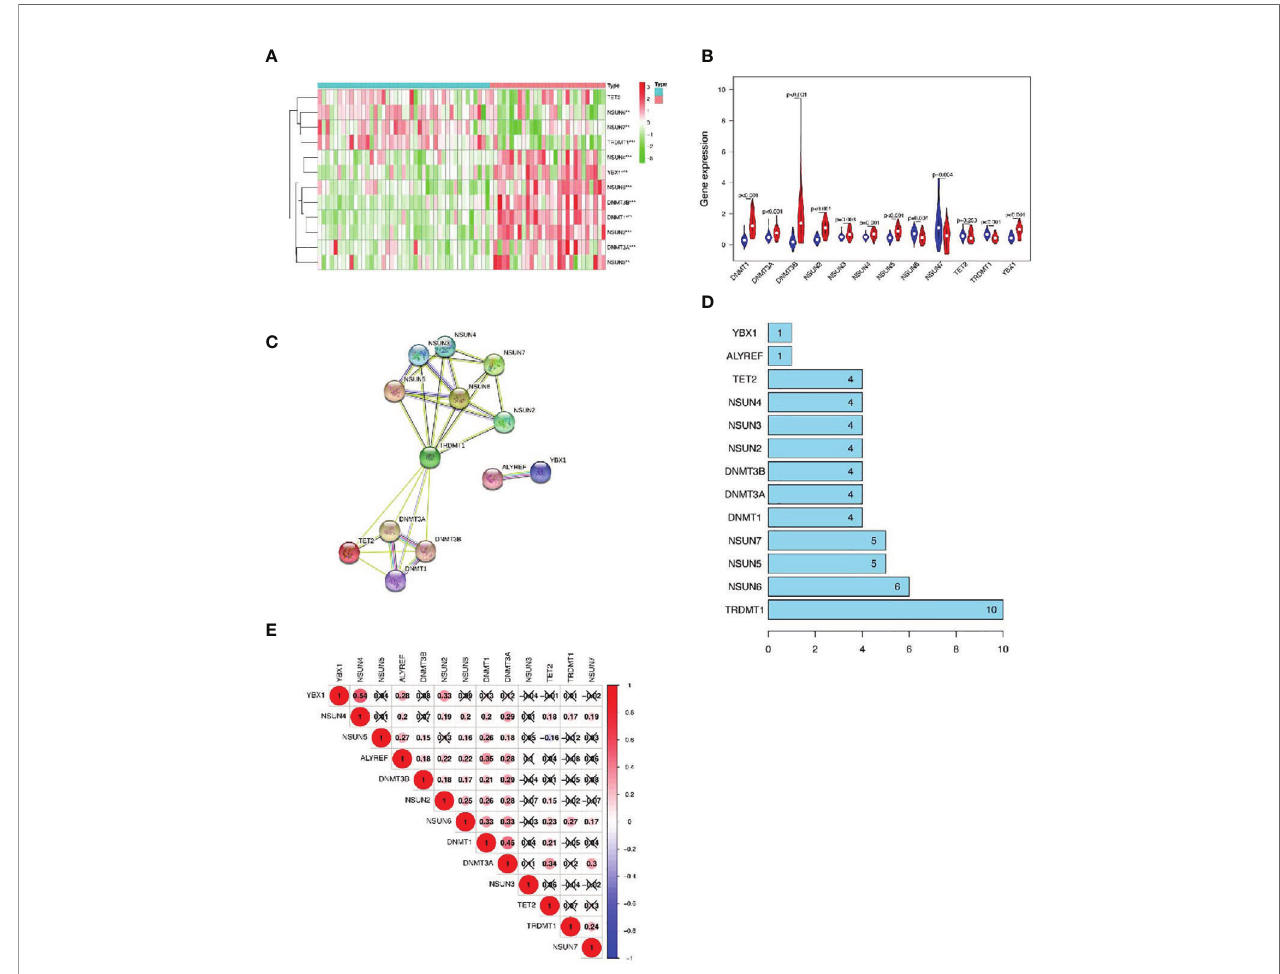
FIGURE 3 | The GEO database veri fi es the differentially expressed genes (DEGs) in m5C regulators and the interaction and correlation between m5C regulators. (A, B) Comparison of m5C regulators between tumor and normal groups in GEO datasets. (C, D) The protein – protein interaction (PPI) network shows the interaction between differentially expressed genes among m5C regulators. (E) The Pearson correlation analysis of the m5C regulators. * p < 0.05,** p < 0.01,*** p <